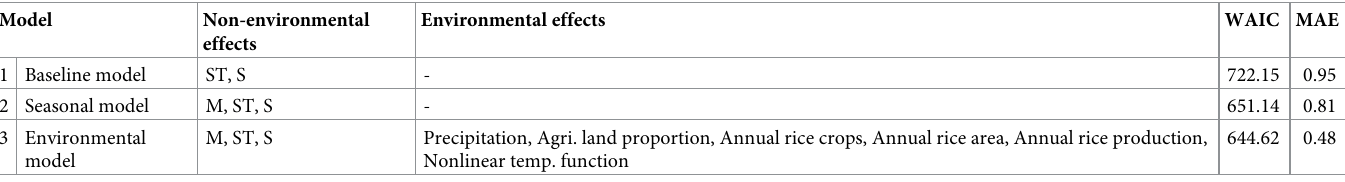
Table 1. Model selection results for models of increasing complexity. The table details the structure of the joint-likelihood models and their corresponding within-sam- ple predictive accuracy assessed on Watanabe-Akaike Information Criterion (WAIC) values. Best models were selected based on minimising WAIC while adhering to model assumptions. Out-of-sample predictive accuracy was compared using mean absolute error (MAE) statistic for random cross validation. Fixed effects included two- month lagged precipitation, proportion of land under agricultural use in 1km radius and district-level measures for annual number of rice crops and total rice area culti- vated and rice produced per year. Mean temperature was included as a second-order random walk function to represent the nonlinear relationship between temperature and vector population dynamics. Non-environmental effects considered were for month (M) and state-level spatial (ST) effects specified as a BYM model and study-level (S) random